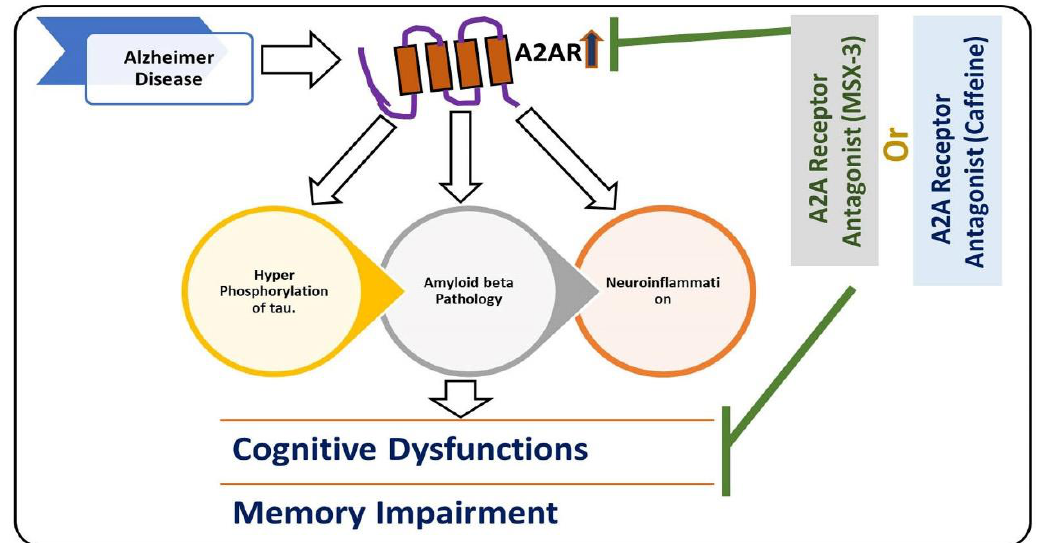
Figure 1. A simple illustration showing the role of reactive oxygen species (ROS) in neurodegenerative diseases. ROS may be produced from different sources, causing the mitochondrial dysfunction, oxidation of proteins, lipid peroxidation, and DNA denaturation, leading to neurodegeneration. The red arrow shows the processing. Red pointing arrow is showing the inducing effects.